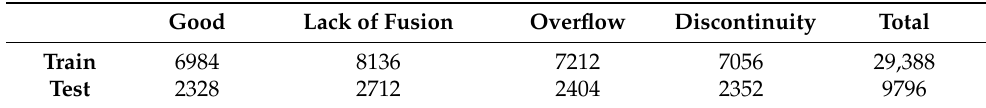
Table 3. The number of images in each category.